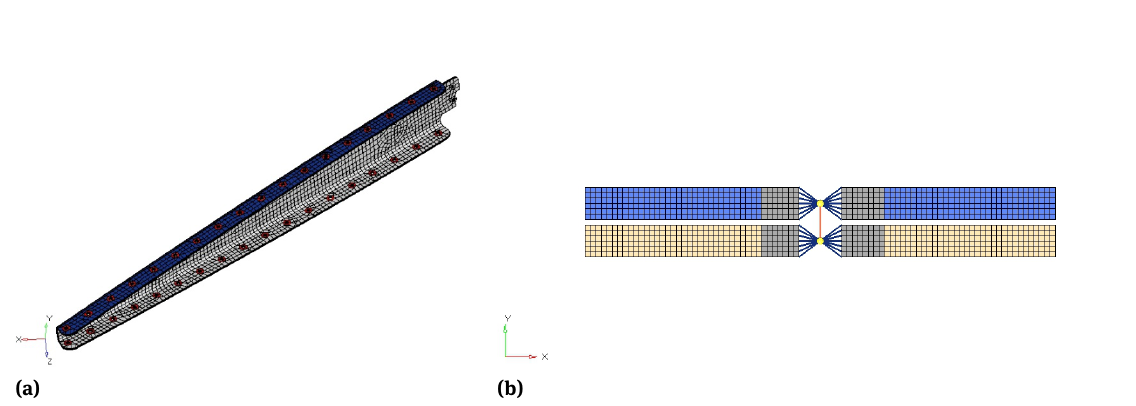
Figure 2: (a) Layered Rib Mesh (b) Fastener Idealization